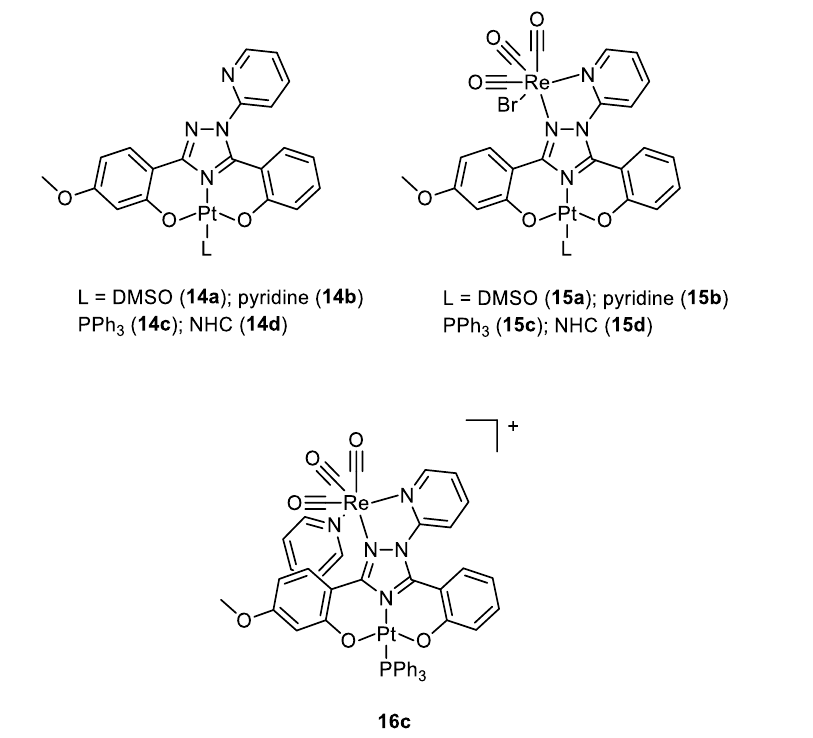
Figure 8. Molecular structure of compounds 14a – d , 15a – d , and 16c . Table 1. Antiproliferative activity of compounds 14a , 15a , 15d , 16c , and cisplatin on different cancer cell lines and the healthy cell line MCF-10F after 72 h of incubation at 37 °C. Partition coefficients of all complexes are reported as Log P o/w . (Adapted with permission from ref. [24]. Copyright 2020 John Wiley and Sons).